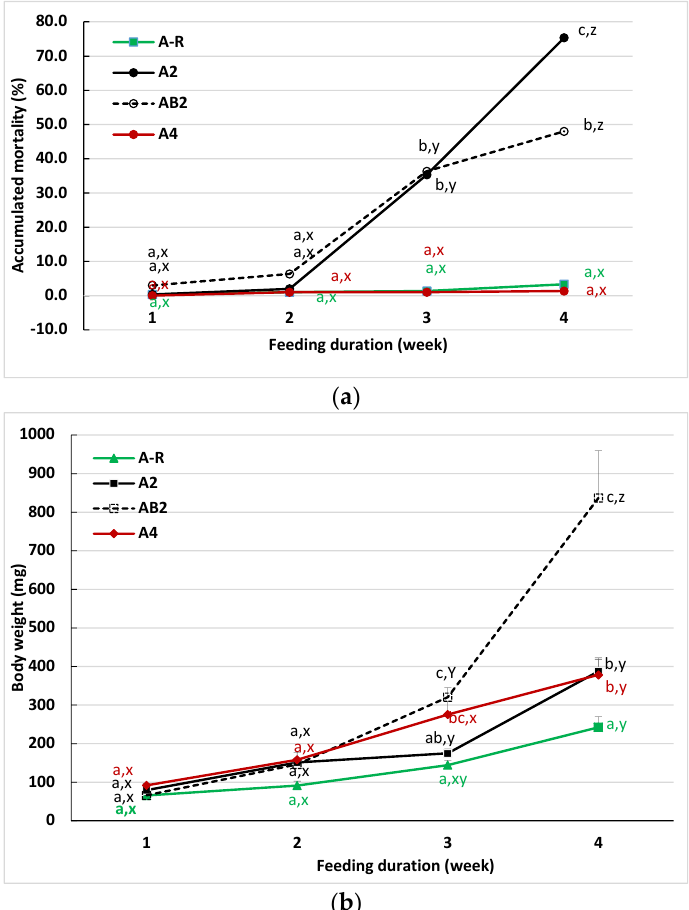
Figure 2. Accumulated mortality ( a ) and average body weight ( b ) of sturgeon fed with different dietary strategies for four weeks (Trial II). Data are presented as the mean of three replications. Means within the same feeding time are compared using letters a, b, and c to indicate significant differences among feeding treatments determined by Tukey’s HSD test ( p < 0.05). Letters x, y, and z compare the difference of different sampling times within the same feeding treatment. See the footnote of Table 3 for the information on feeding treatments.